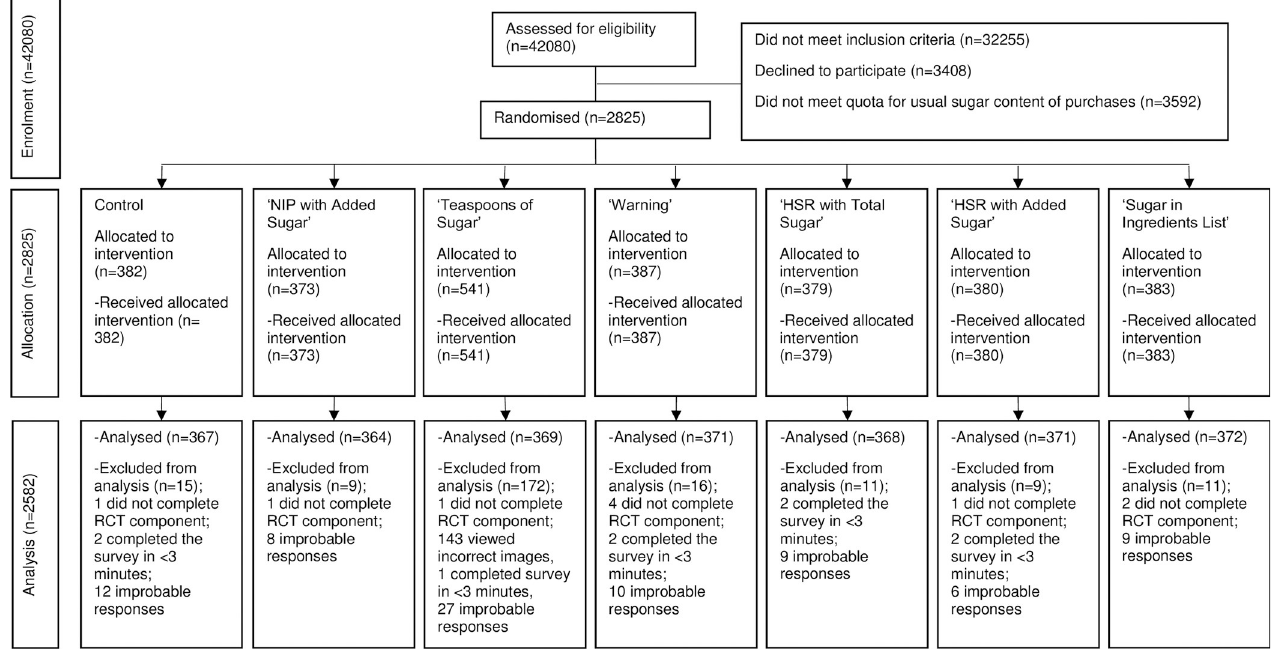
Fig 2. CONSORT flow diagram. HSR, Health Star Rating; NIP, Nutrition Information Panel; RCT, Randomised Controlled Trial. 143 subjects who were allocated to the ‘Teaspoons of Sugar’ labelling condition were assigned to a version with an error in the images and were excluded from the analysis. Additional participants were recruited for this